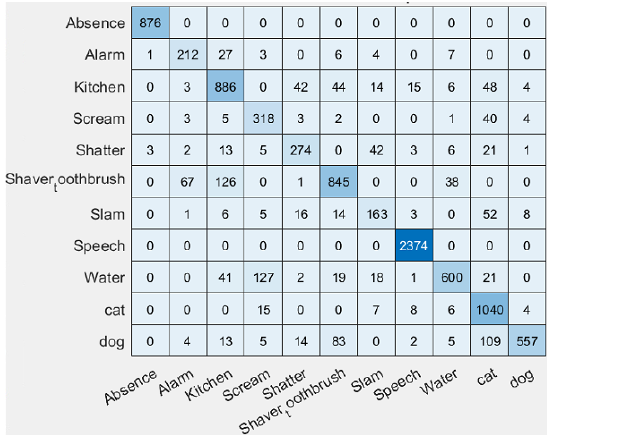
Table 4. Average execution time for inference (in